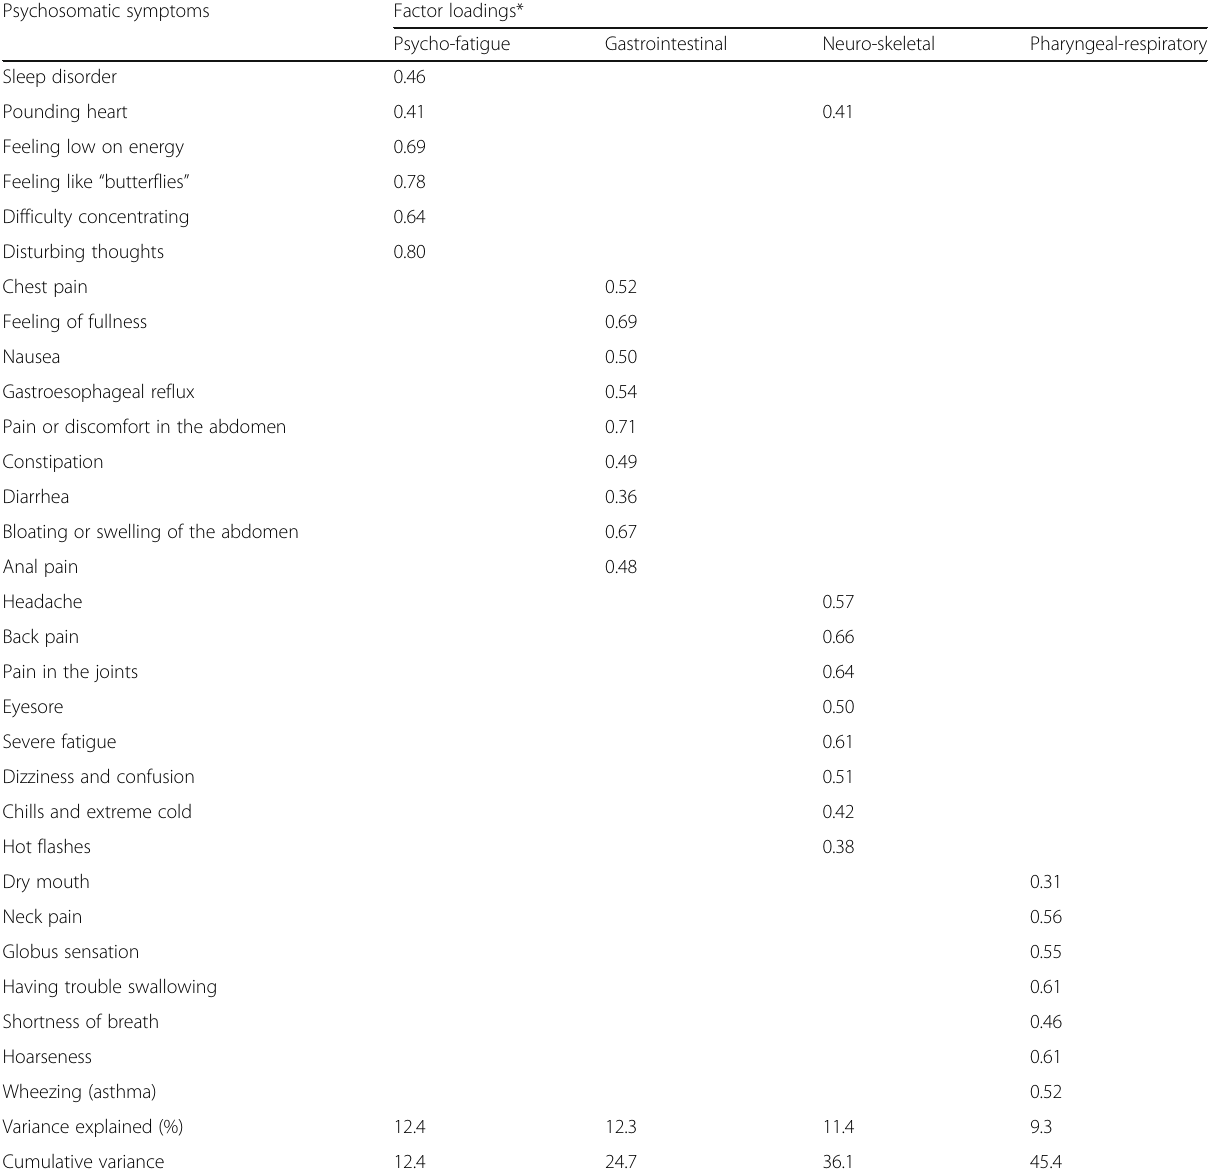
Table 3 Factor loadings for the four extracted psychosomatic disorder profiles from psychosomatic symptoms Psychosomatic